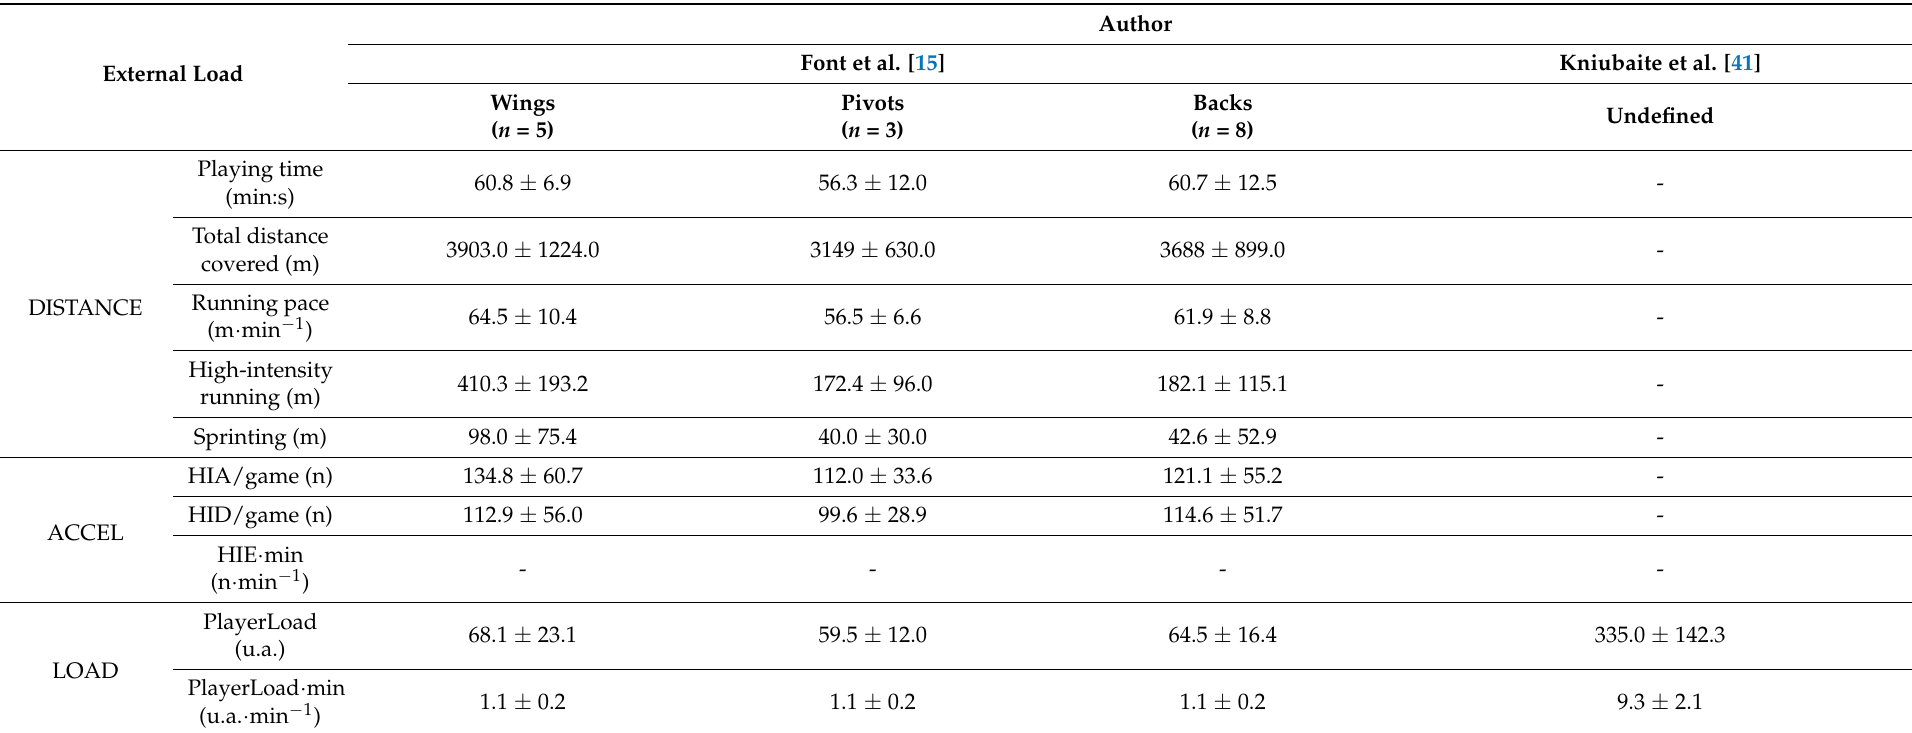
Table 2. External load variables based on the local positioning